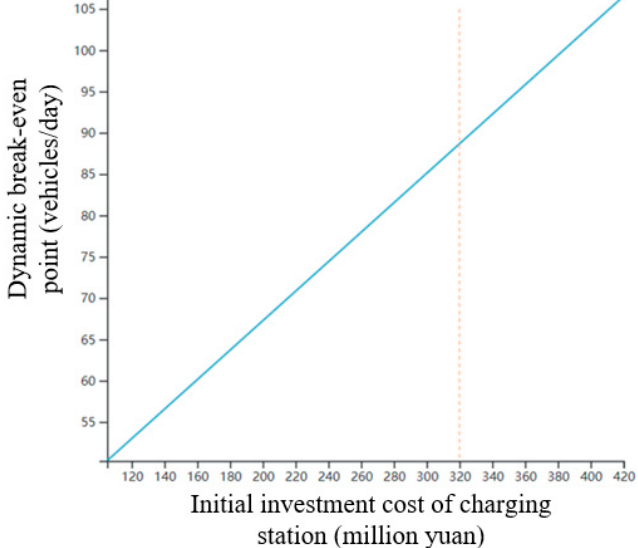
Figure 9. Sensitivity analysis of the initial investment cost of the charging station.